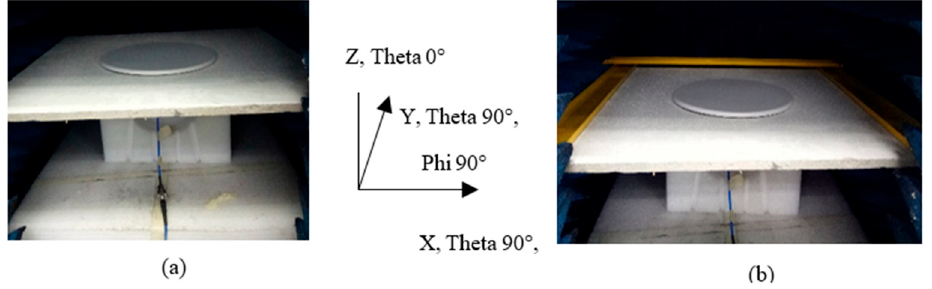
Figure 30. Photo of the proposed antenna on the top of acoustic ceiling tiles ( a ) without and ( b ) with half of the metal frame.